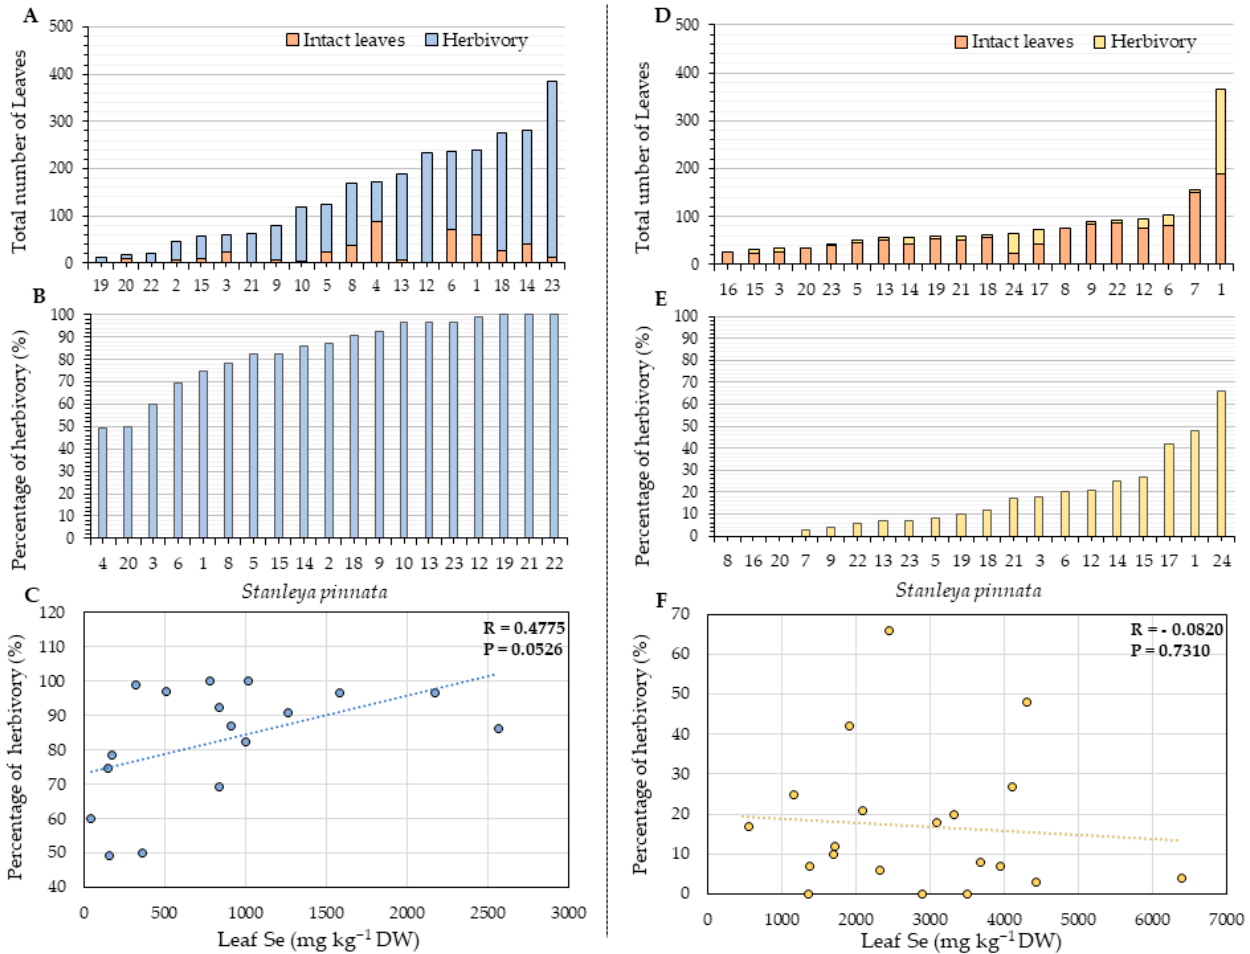
Figure 5. Total number of leaves with and without signs of herbivory per plant ( A , D ). The state of herbivory is represented as the percentage of leaves with herbivory per plant ( B , E ). Correlation between leaf Se concentration with herbivory ( C , F ) for S. pinnata plants growing at Coyote Ridge ( A – C ) and Pine Ridge ( D – F ). The numbers on the horizontal axis ( A , B , D , E ) represent the collection numbers of individual plants at the locations indicated in Figures 2 and 3. The graph shows the correlation coefficient R and p -value for panels ( C , F ). Coyote Ridge samples were collected in September Pine Ridge samples in May when herbivory damage was lower.